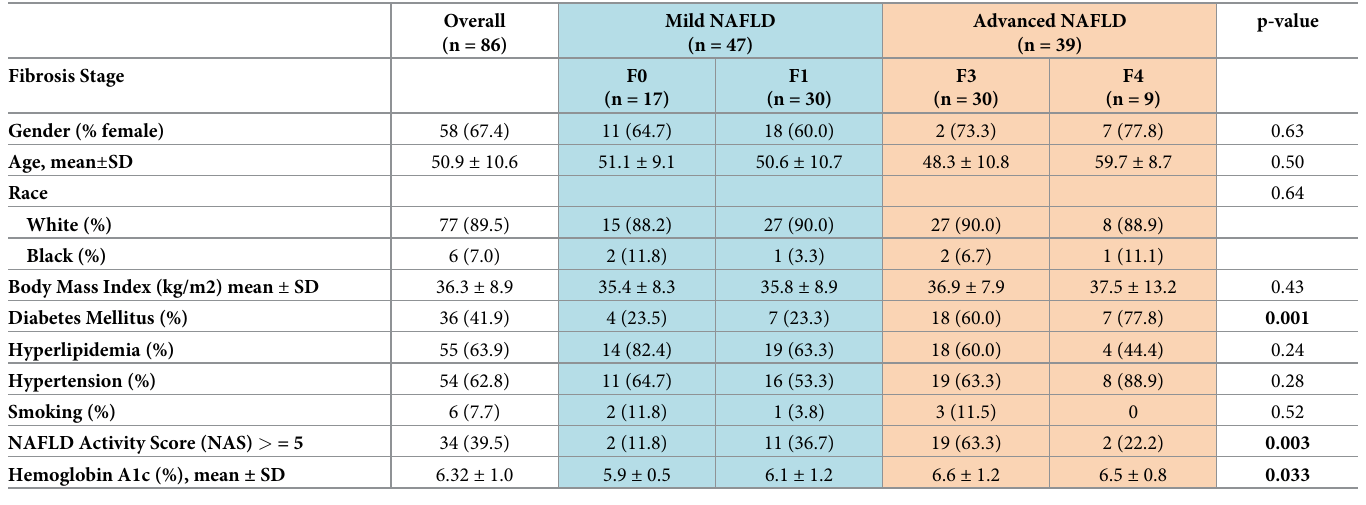
Table 1. Patient characteristics at baseline. P-values reflect fibrosis stage comparisons.